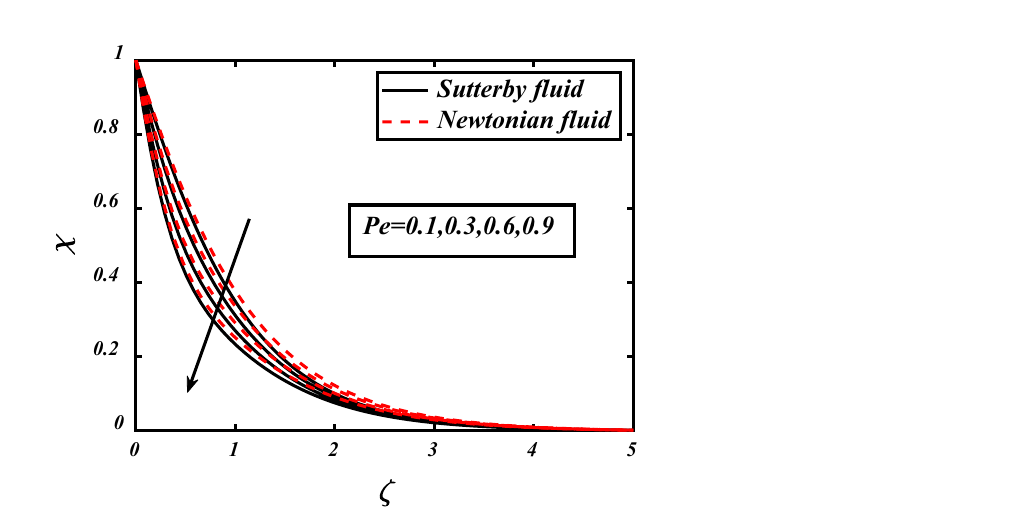
Figure 15. expounds the impacts of Pe on χ